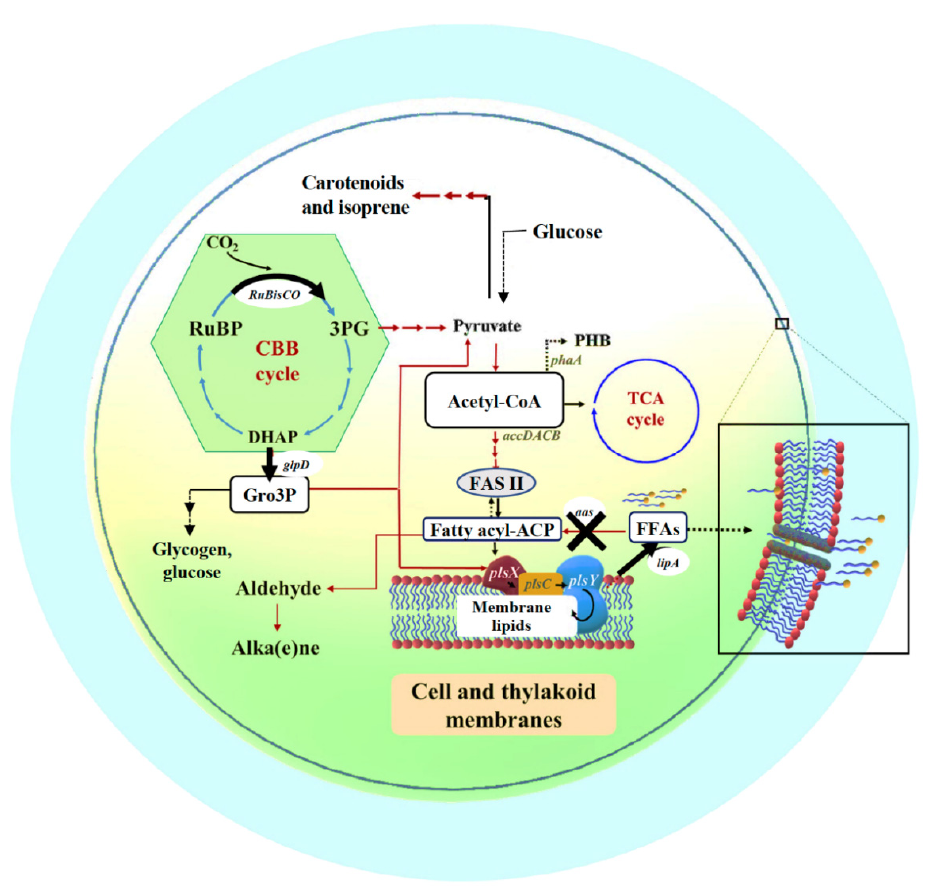
Figure 1. Outline of intracellular lipid production and FFA secretion into cultured medium system in cyanobacteria. Key enzyme-encoding genes (represented in italic letters) associated with lipid and fatty acid synthesis, the Calvin–Benson–Bassham (CBB) cycle, polyhydroxybutyrate (PHB) synthesis, and free fatty acid (FFA) recycling, including accDACB , a multi-subunit acetyl-CoA carboxylase gene; lipA , a lipolytic enzyme-encoding gene; aas , acyl-ACP synthetase gene; plsX , plsY and plsC , putative phosphate acyl-transferases genes; and phaA , acetyl-CoA acetyltransferase gene; the RuBisCO gene cluster, including rbcLXS , encoding RuBisCO in respective order of large, chaperone and small subunits; glpD , glycerol-3-phosphate dehydrogenase gene. The abbreviated intermediates and products are: DHAP, dihydroxyacetone phosphate; fatty acyl-ACP, fatty acyl–acyl carrier protein; FFAs, free fatty acids; Gro3P, glycerol-3-phosphate; 3PG, 3-phosphoglycerate; PHB, polyhydroxybutyrate; RuBP, ribulose-1,5-bisphosphate. The thick arrows represent the overexpression (O) of indicated genes whereas the cross symbol represents knockout (K) of indicated gene.